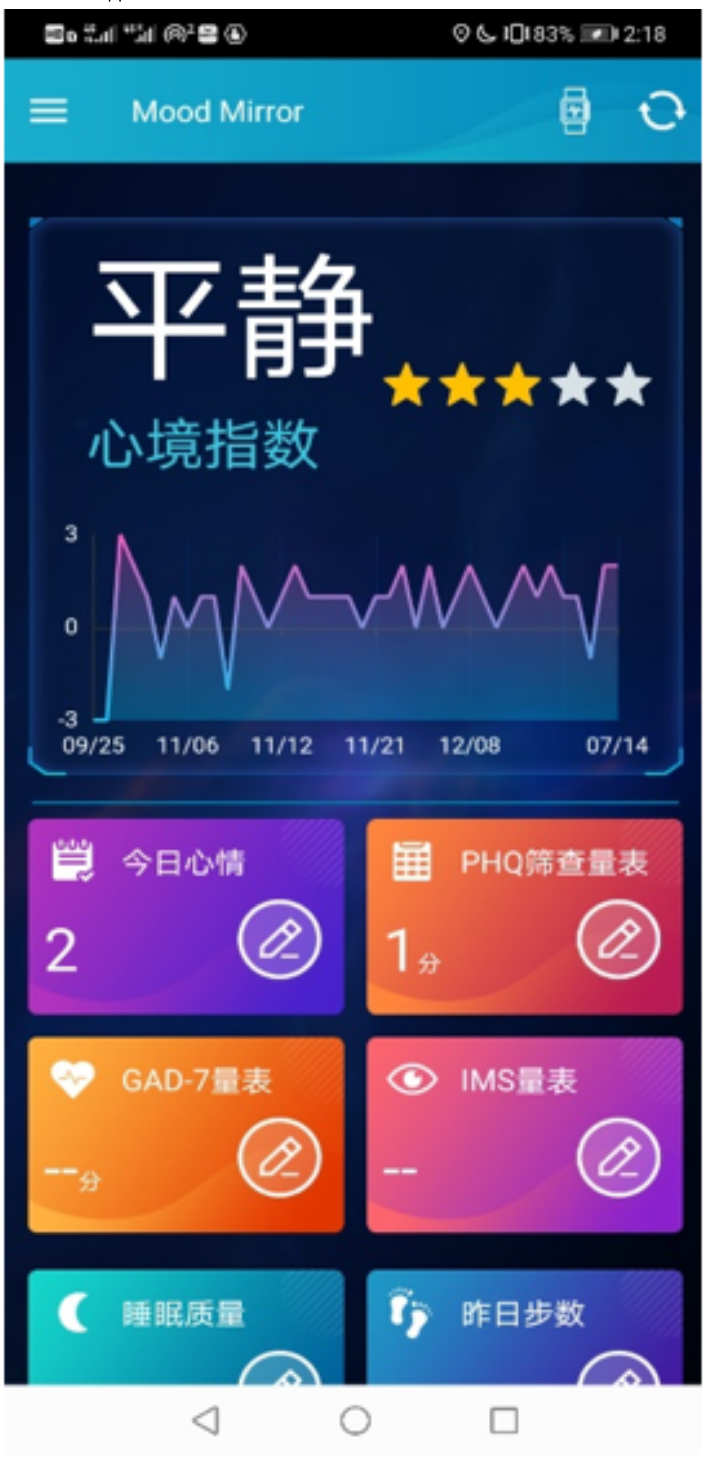
Figure 1. Home screen of the Mood Mirror